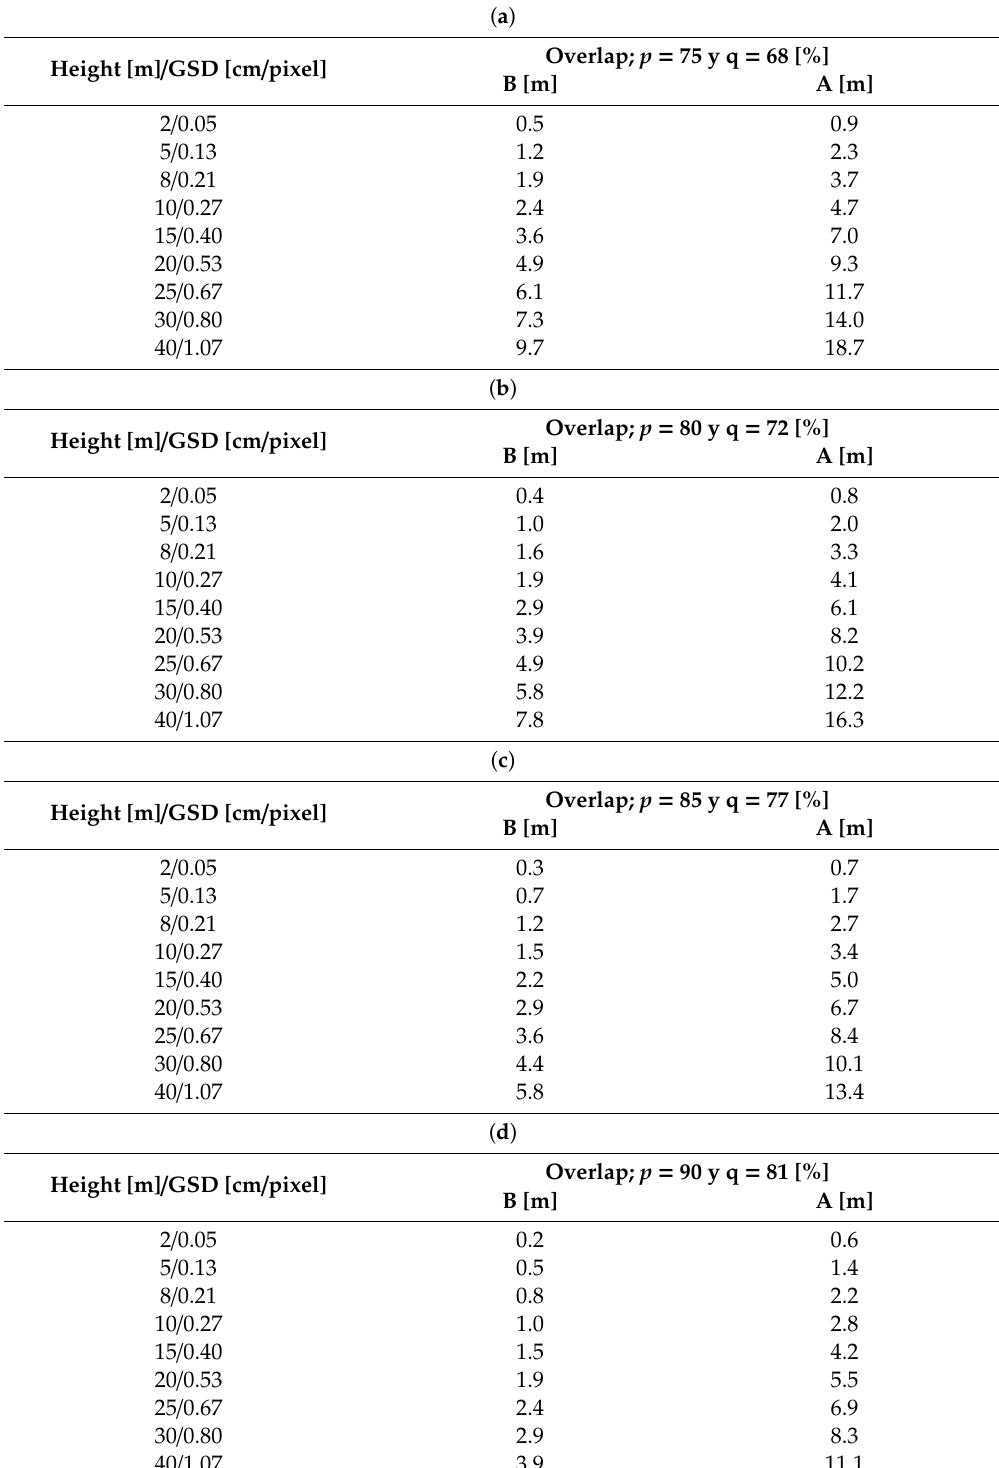
Table 5. Recommended distances to meet optimal height overlap. ( a ) p = 75, q = 68 [%]; ( b ) p = 80, q = 72 [%]; ( c ) p = 85, q = 77 [%]; ( d ) p = 90, q = 81